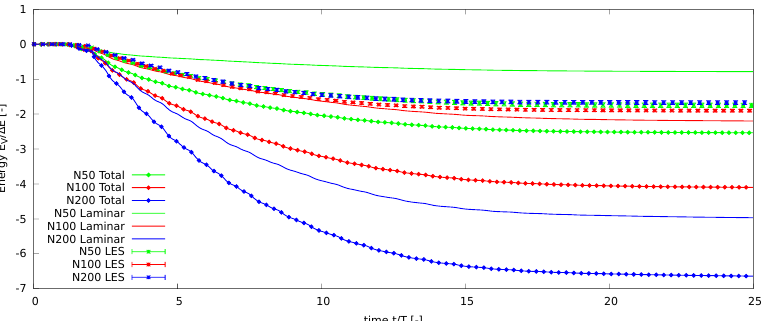
Figure 21. Oil energy dissipation showing the loss ( top ) and viscous dissipation ( bottom ).